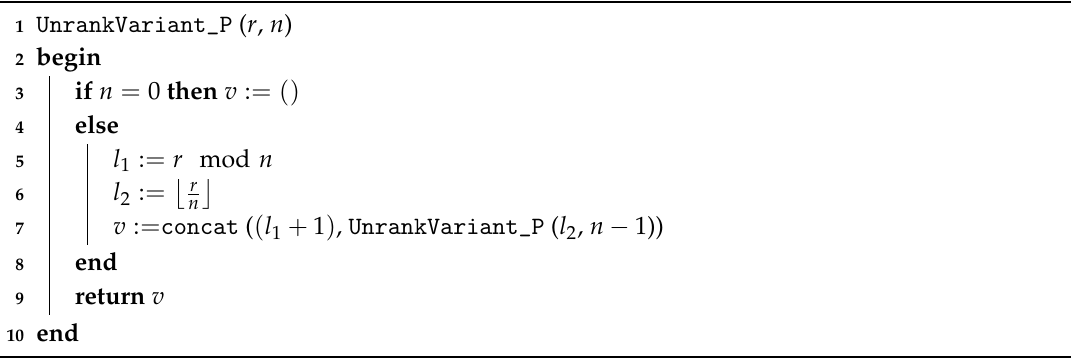
Algorithm 10: An algorithm for unranking the variants of the AND/OR tree for P n